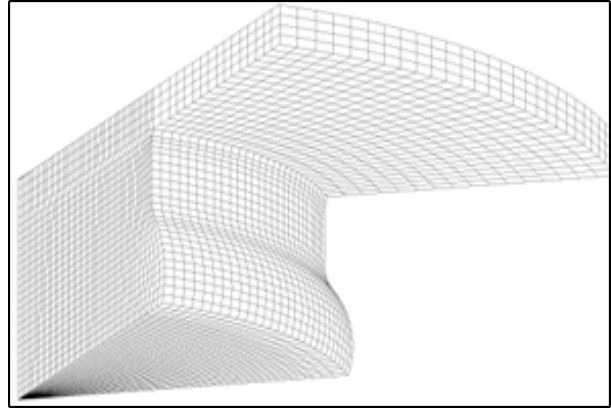
Figure 12. Mesh#4. Figure 12.